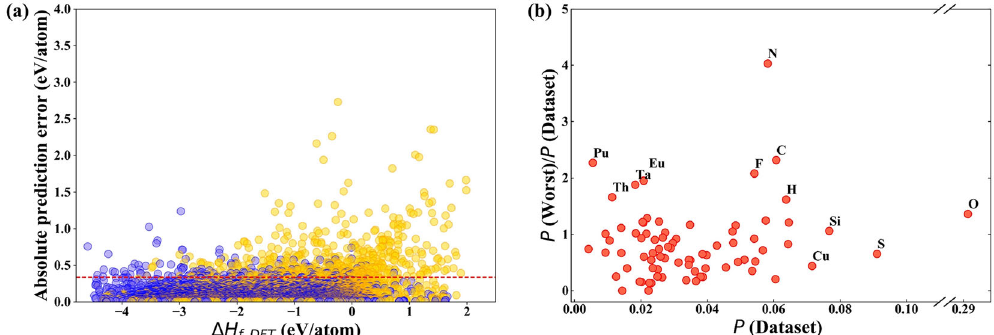
Fig. 3 Analysis of ML model prediction error. a An illustration of the DFT-calculated formation enthalpies of various compounds and their absolute prediction errors in 10-fold cross-validations. The red dashed line refers to the error value to which 98% of absolute prediction errors are smaller or equal. The yellow dots indicate that the ML predicted values are less than those of the DFT while the blue dots are the opposite. b An illustration of the occurrence probabilities of various elements in the whole dataset P (Dataset) vs. the ratios of their occurrence probabilities in the set of 2% highest prediction errors [ P (Worst)] over P